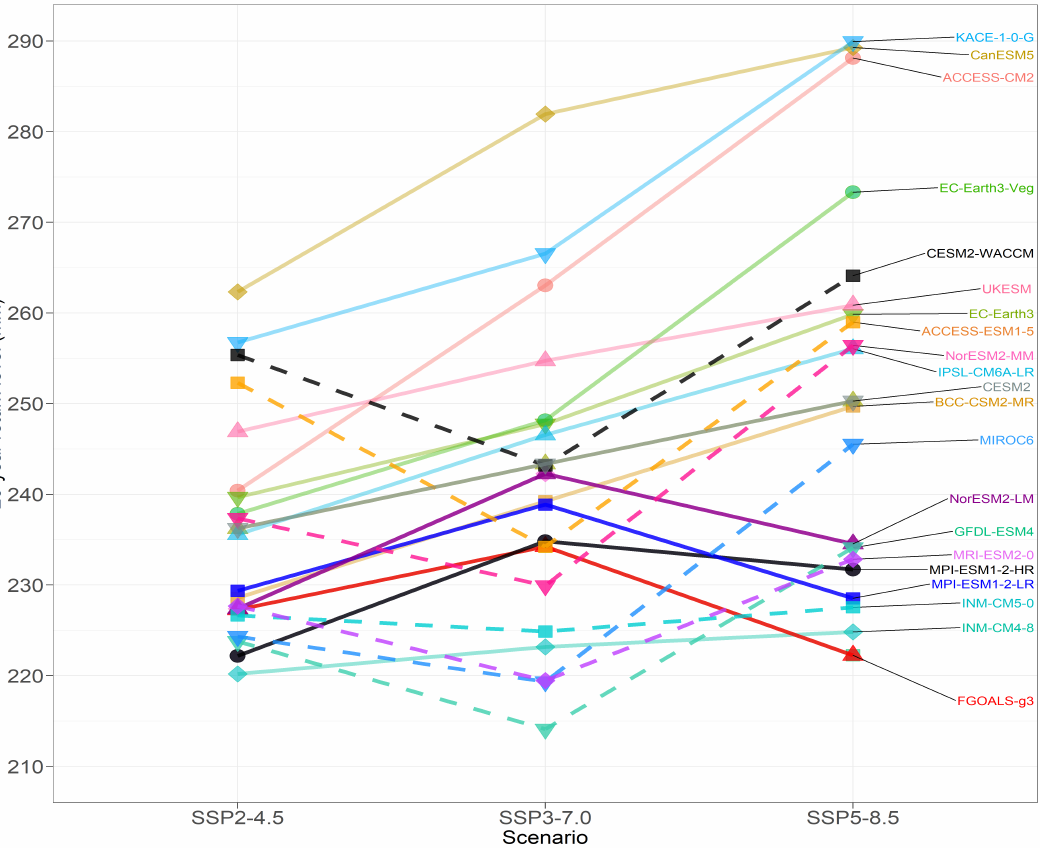
Figure 11. Interaction plots of the 20-year return levels from the 21 CMIP6 models for three SSP scenarios averaged over three periods and 46 grids in the Korean